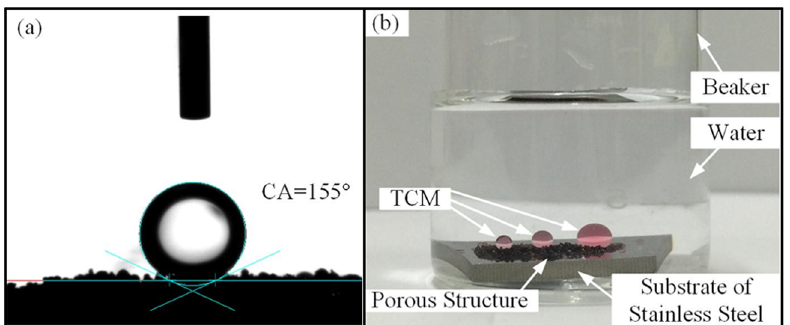
Figure 4: In - water super - oleophobic and hydrophilic behavior of the HMS sample showing a 155° CA with Oil - Red O dyed TCM and a nearly 0° water CA; ( a ) in - water CA measurement with TCM; ( b ) tests with the in - water TCM ( Oil - Red O dyed ) showing the super - oleophobic capability.